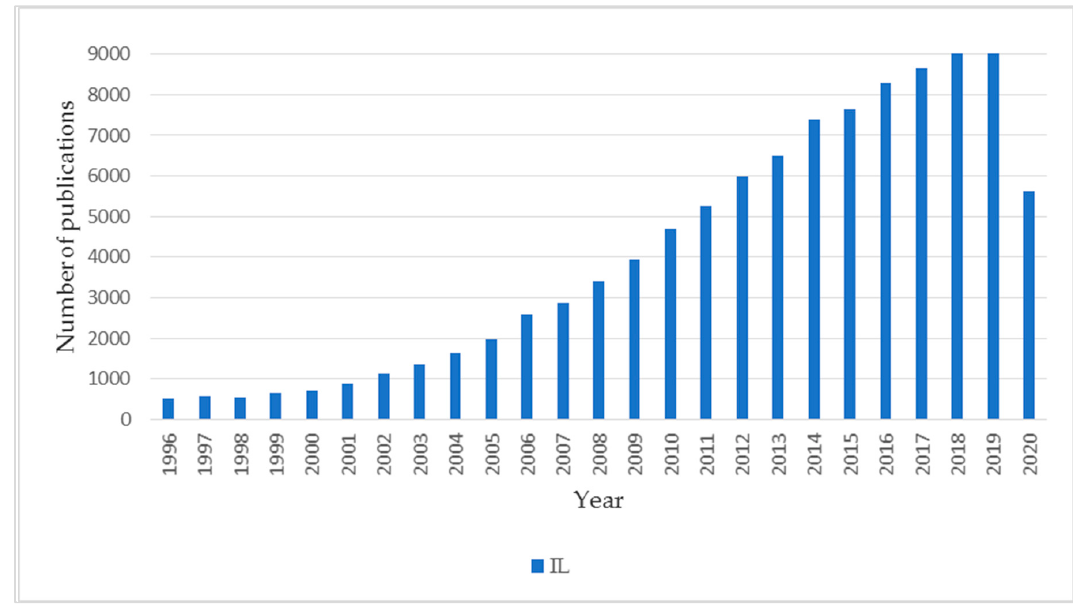
Figure 1. Number of publications on ionic liquids in the period 1996–2020. Catalysts 2020 , 10 , x FOR PEER REVIEW